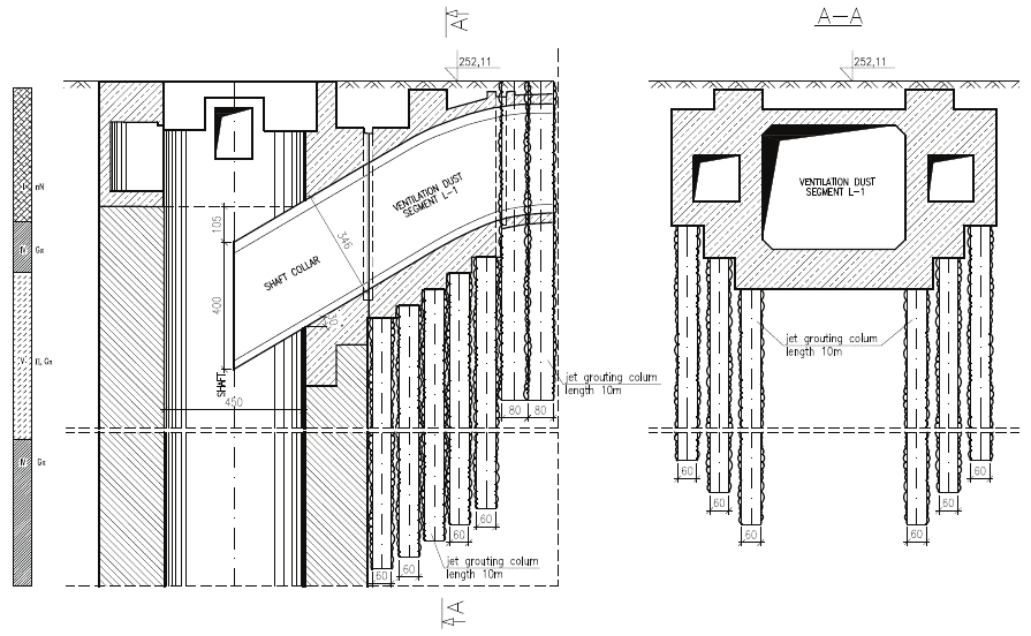
Fig. 4. Location of grout